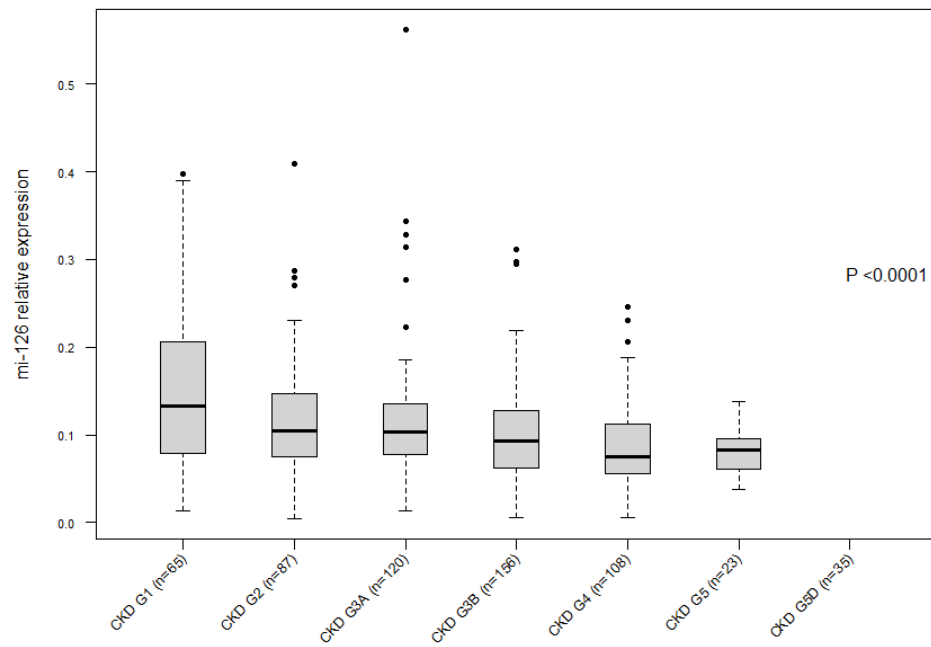
Figure 1. Seric expression of miR-126 decreases according to the CKD patient’s stage.